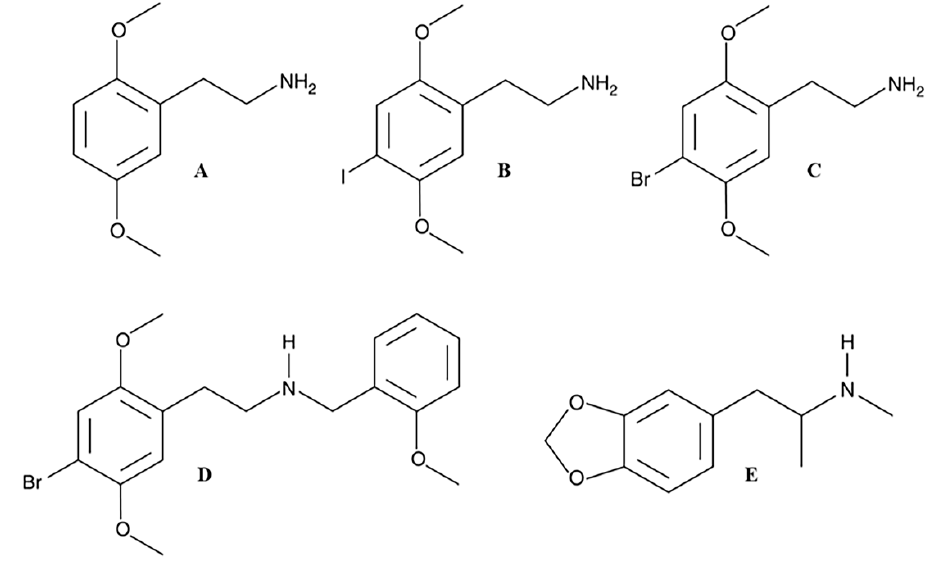
Figure 1. Chemical structures of 2C-H ( A ), 2C-I ( B ), 2C-B ( C ), 25B-NBOMe ( D ), and MDMA ( E ).